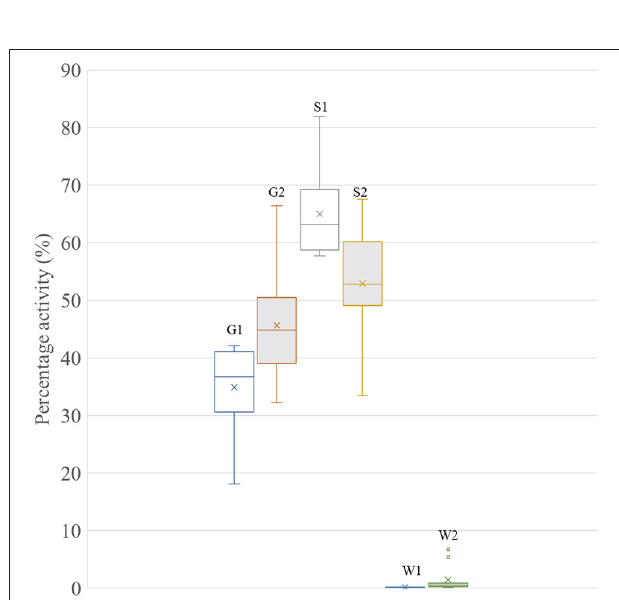
FIGURE 3 | Box-whisker plot showing the percentage activity of ewes in the once (1) or twice (2) shearing treatments. G, grazing; S, standing; and W, walking. Level of significant difference between the groups was p < 0.05 for each activity